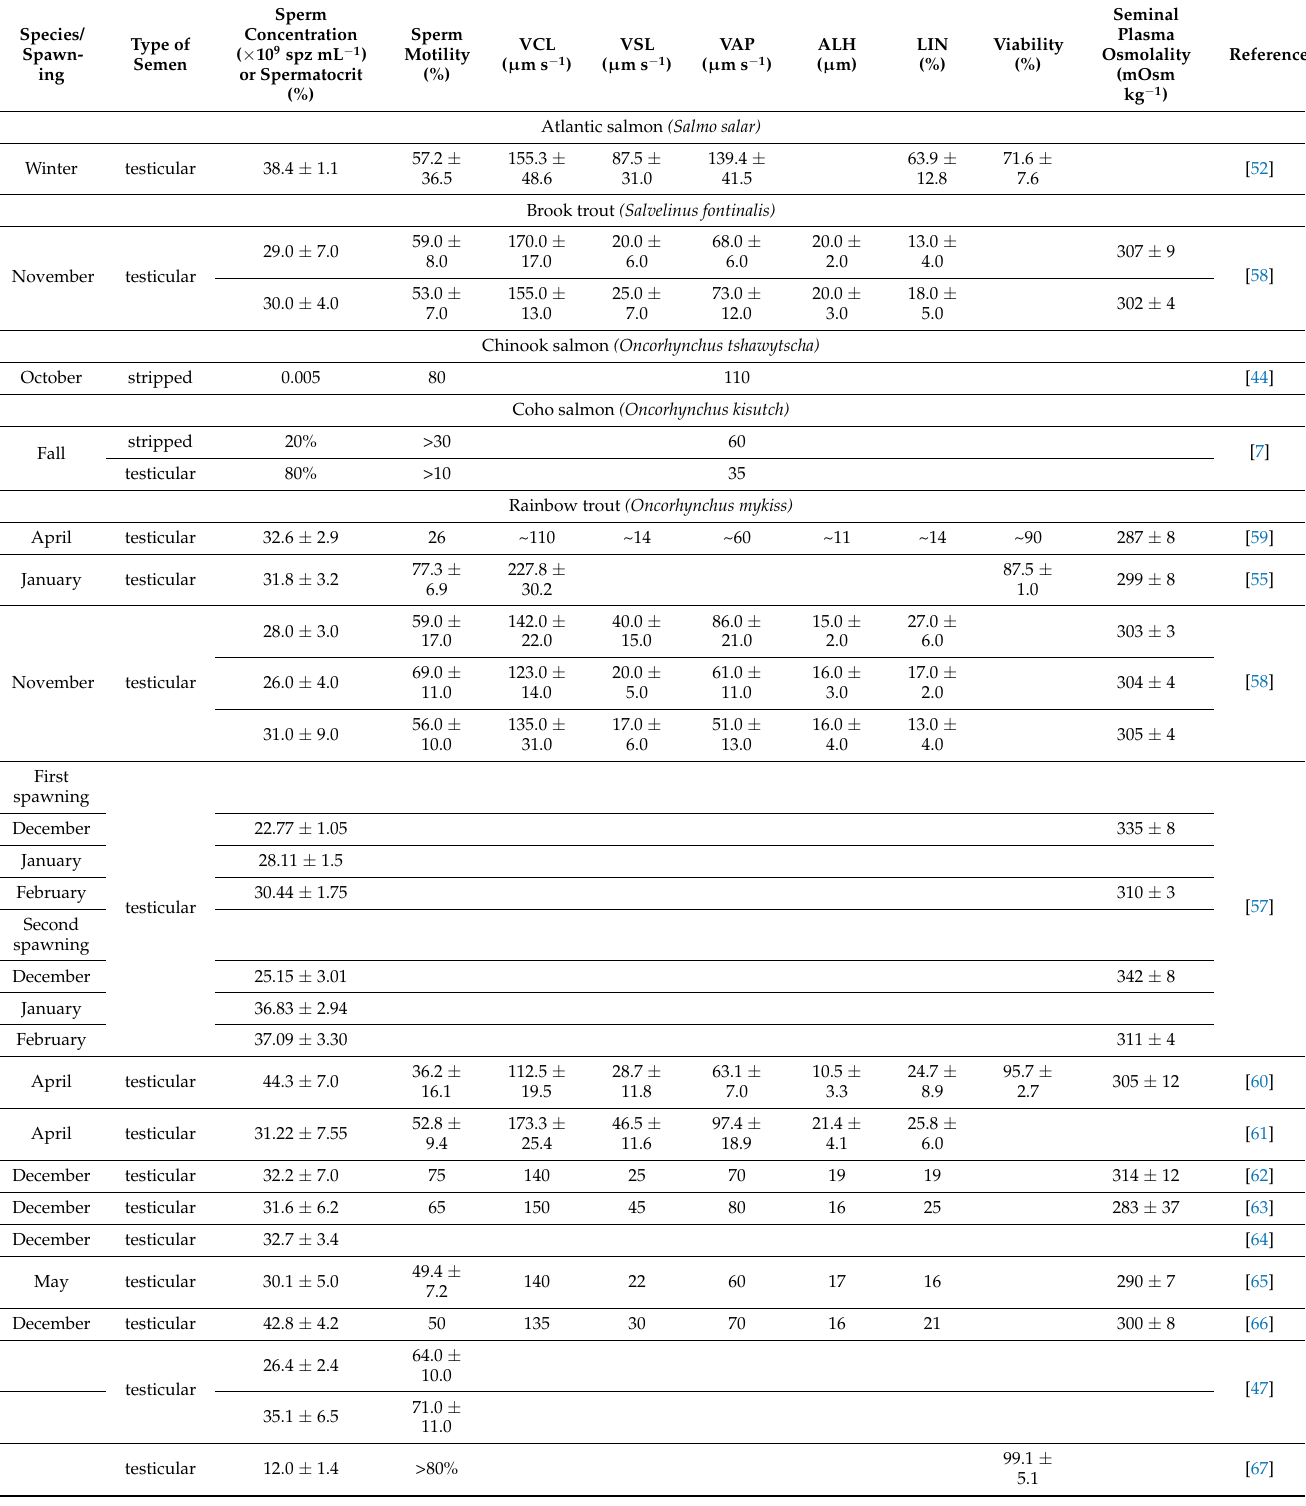
Table 3. Characteristics of the fresh semen in salmonid